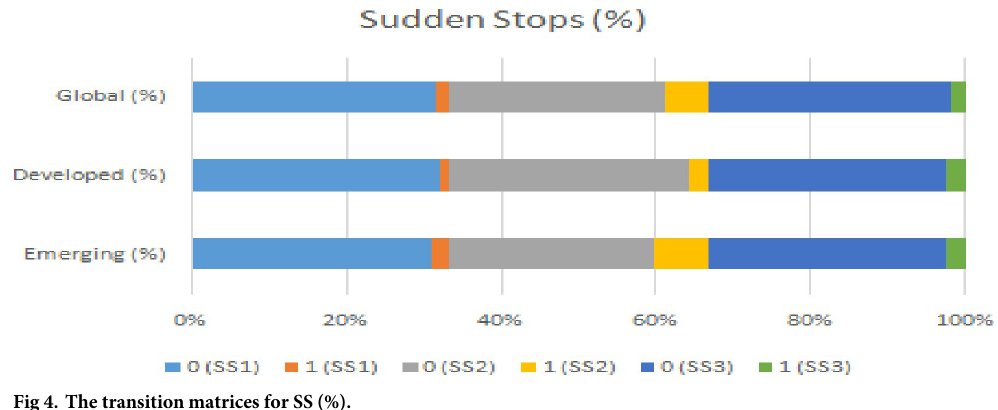
Fig 4. The transition matrices for SS (%).